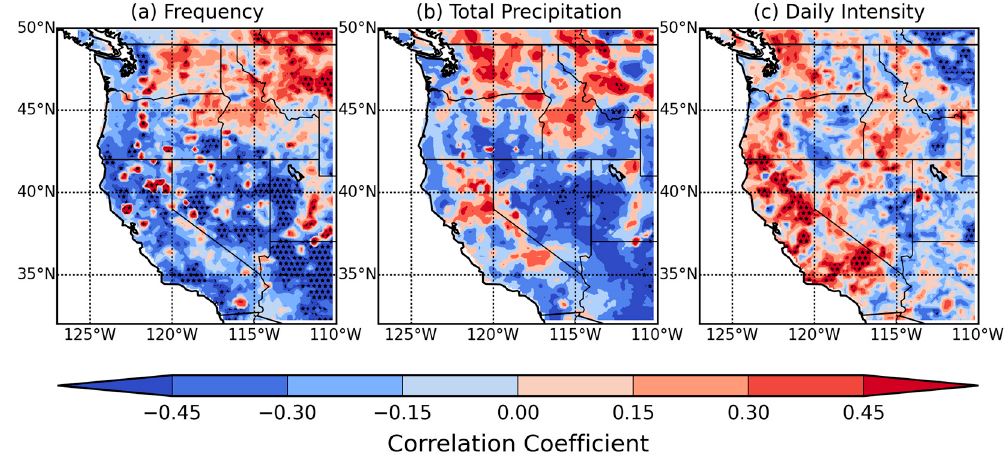
Figure 8. The correlation coefficient between the surface temperature and winter season precipitation ( a ) frequency, ( b ) seasonal total, and ( c ) mean daily intensity over the western United States between December-January-February (DJF) 2003 and 2016. Hatching indicates areas of statistical significance.